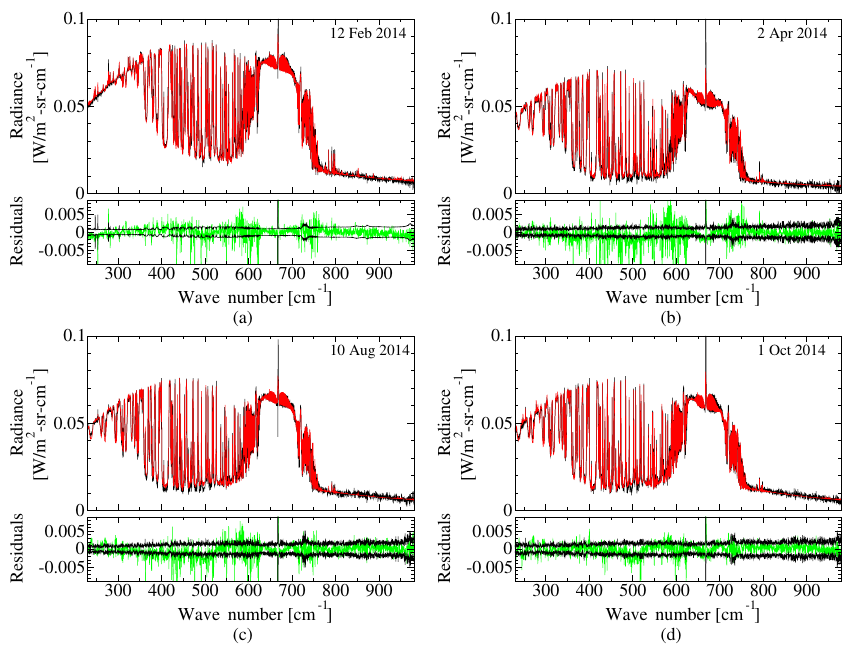
Figure 8. Comparisons of the synthetic spectra (red) provided by the retrieval with the measurements (black) nearest to 12:00UTC for the same days shown in Fig. 6. The lower panels show the comparisons of the residuals (green) with the measurement uncertainty (black).